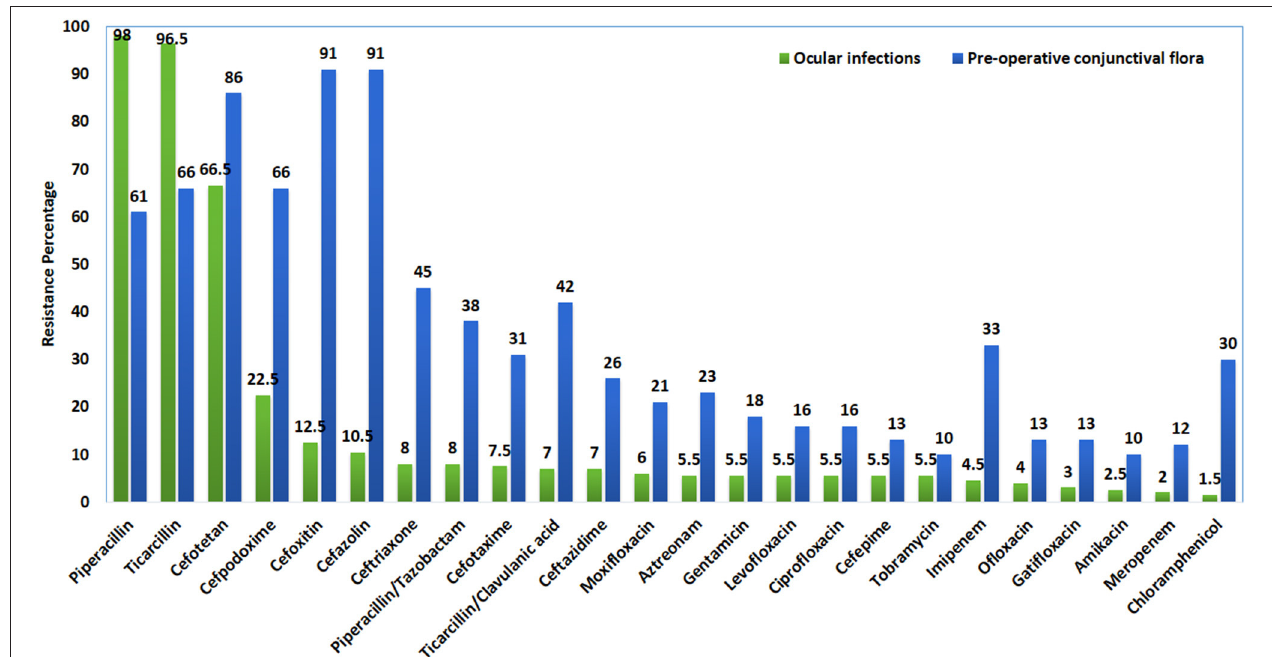
FIGURE 1 | Comparative in-vitro antibiotic resistant profile of isolates from eye infections and pre-operative conjunctiva.